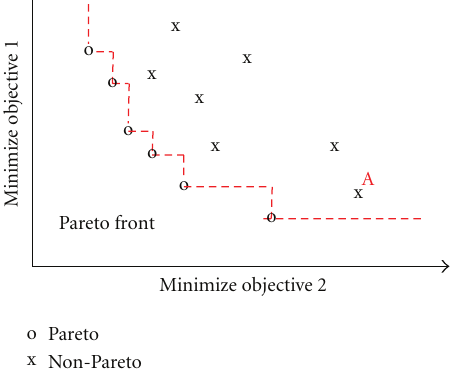
Figure 2: Pareto front of solutions.